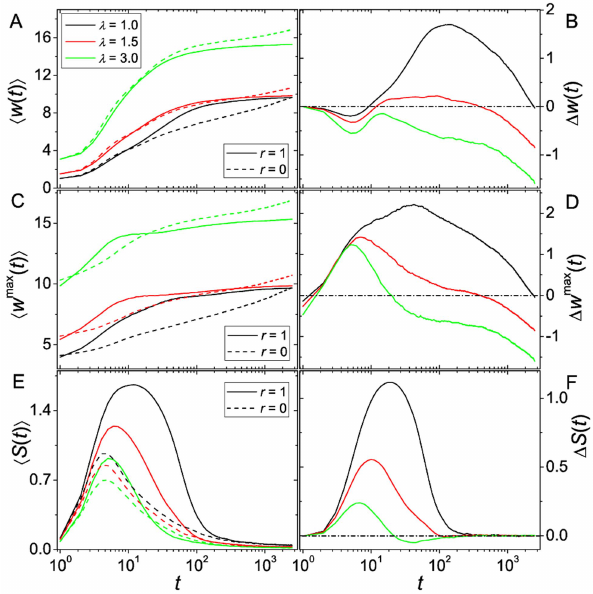
Figure 1. Advantage of recombination on a smooth fitness landscape. The figure shows time series of (A) mean fitness S w T and (B) difference of the mean fitnesses D w for recombining ( r ~ 1 ) and non- recombining ( r ~ 0 ) populations in an additive landscape. Time t is measured in discrete generations. Population parameters are N ~ 1000 , N m ~ 8 , and the slope of the additive fitness landscape is c ~ 1 . Although not visible to the naked eye, D w converges to a value below zero at long times.